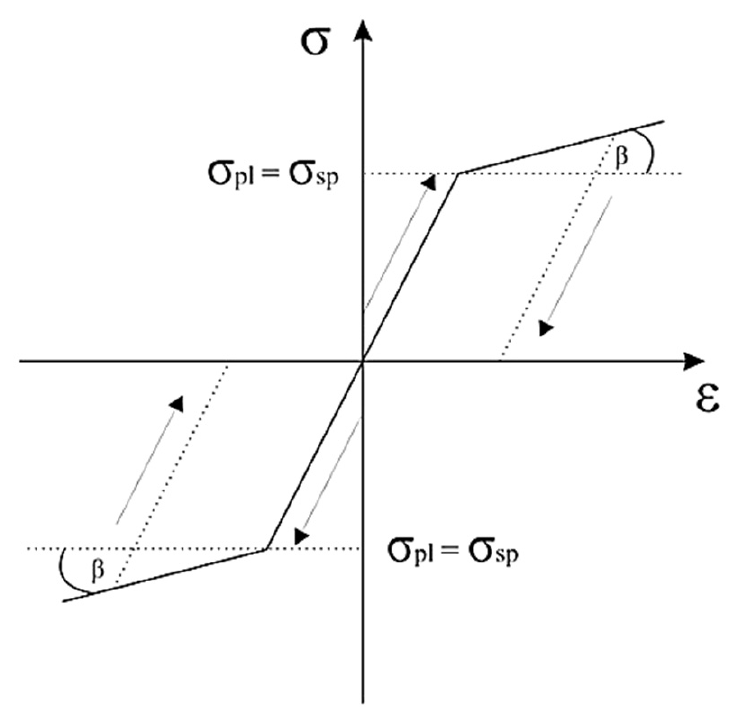
Figure 2. Prandtl-Reuss model curve σ = f( ε Figure 2. Prandtl ‐ Reuss model curve σ = f( ε ).